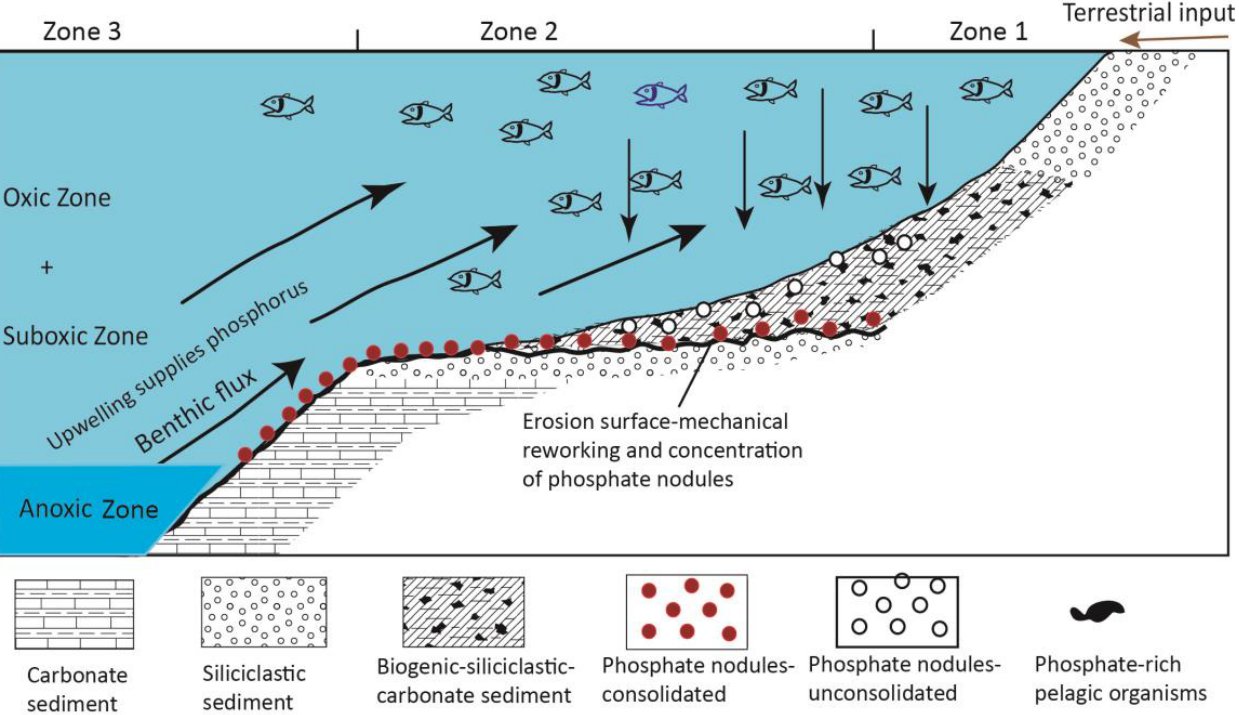
Figure 9. Genetic model for the phosphate nodules formed in areas of upwelling on open ocean shelves. Zone 1 forms from near-shore, shallow-water siliciclastic deposits. Zone 2 contains both phosphate-rich biogenic detritus in sediments and phosphate nodules formed in this zone by diagenetic processes. Zone 3 consists of carbonate sediments containing local phosphate nodules in the deeper water zone. Data from [111,112].